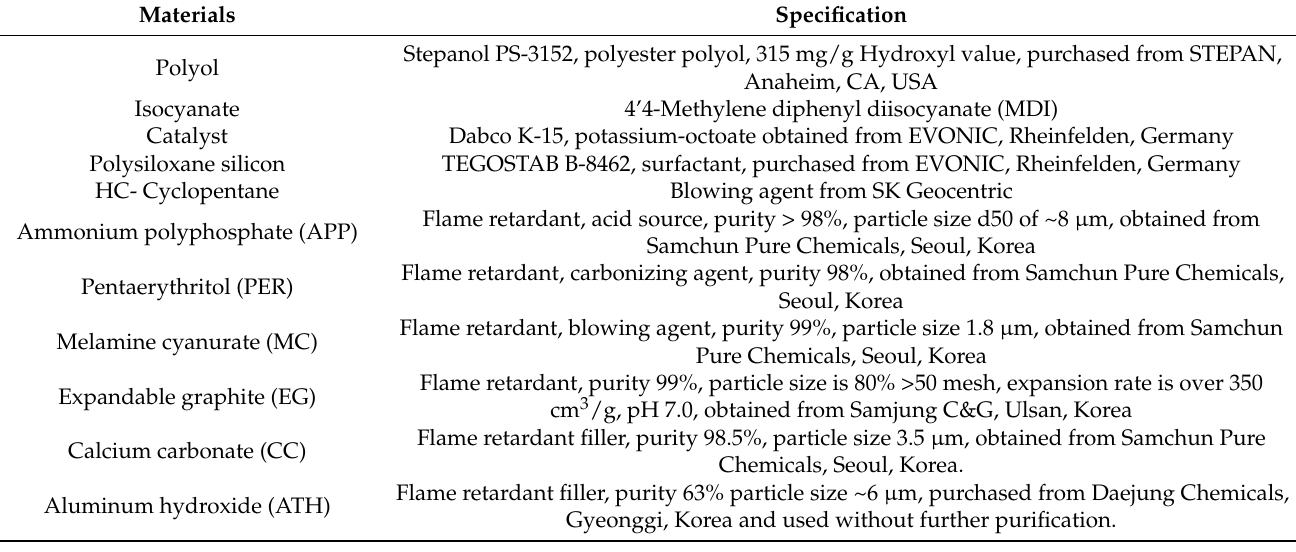
Table 1. Specifications of the materials used in this work.